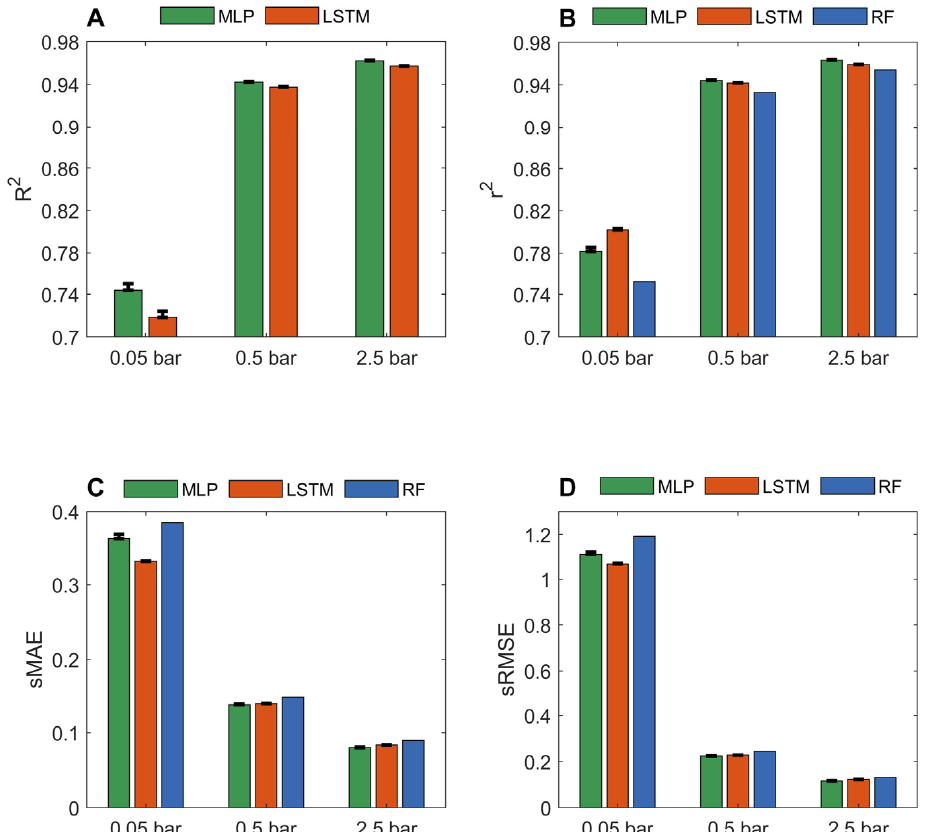
Figure 3. Performance of MLP and LSTM models measured in R 2 ( A ); r 2 ( B ); sMAE ( C ); and sRMSE ( D ). The averaged performance metrics from the 10 iterations of 10-fold cross validations were plotted as green and red bars for MLP and LSTM models, respectively. The corresponding standard deviations were plotted as sticks above the bars. The reported results of random forest models from the same datasets [36] were plotted as blue bars.